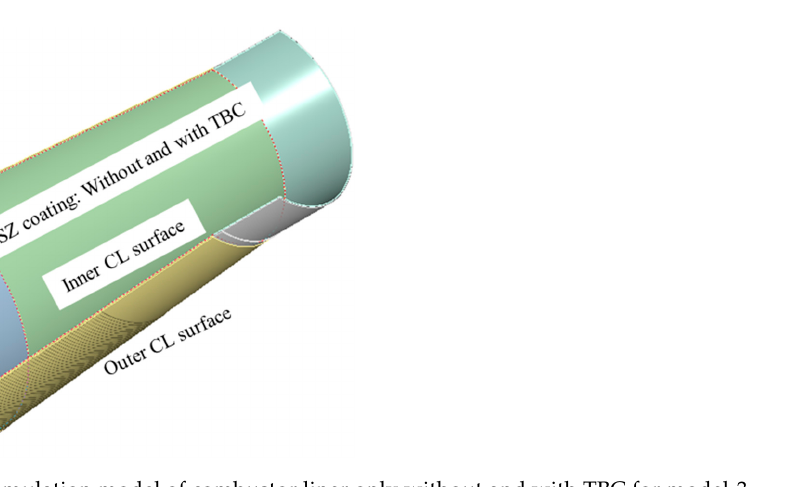
- Table 4. Properties of Yttria Stabilized Zirconia (YSZ).